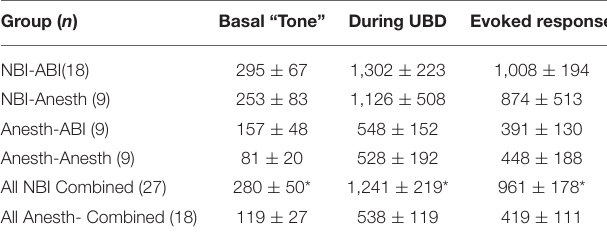
TABLE 2 | Electromyographic activity (mean mV) of the left pubococcygeus muscle in female rats which had experienced NBI and/or ABI. Group ( n ) Basal “Tone” During UBD Evoked